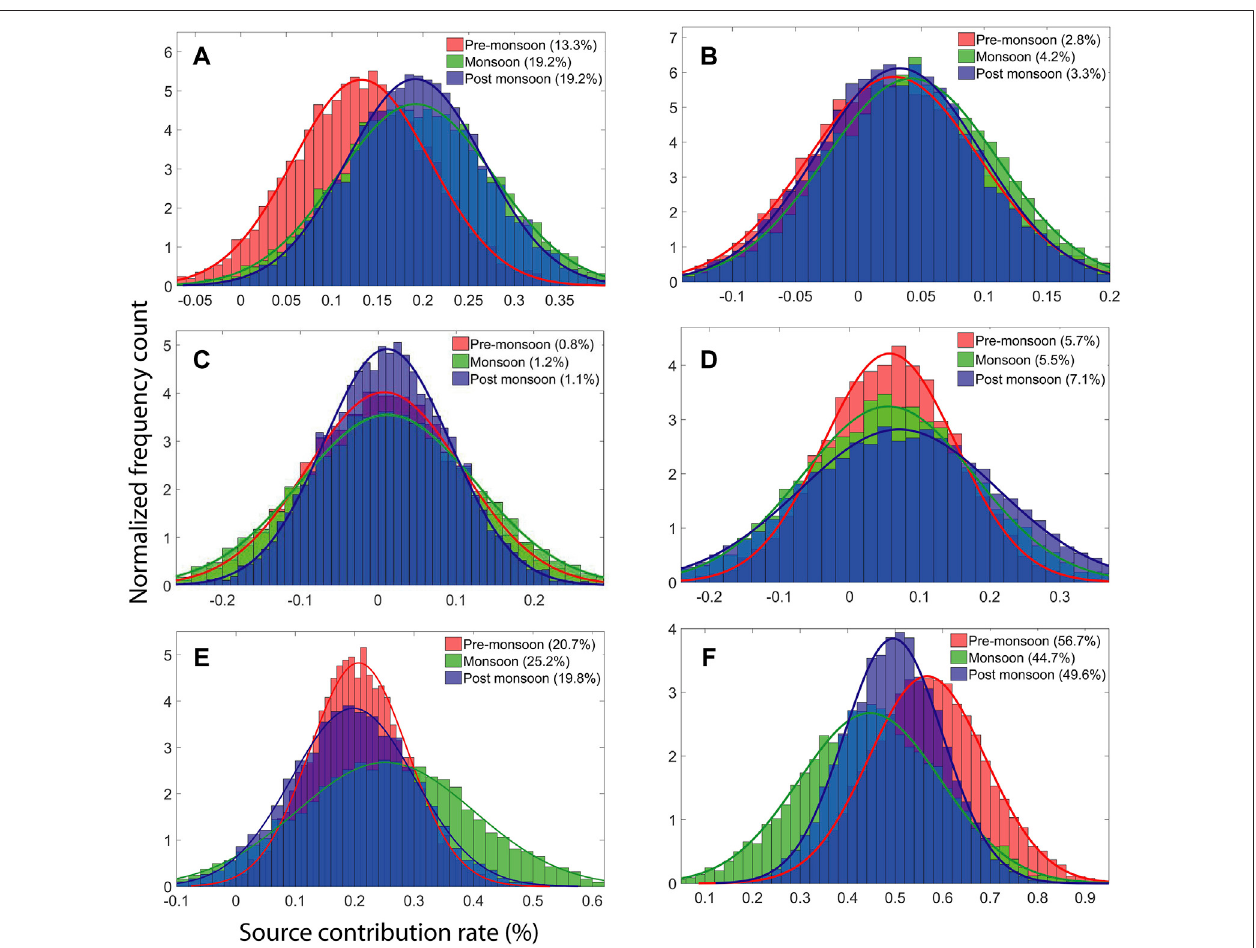
FIGURE 7 | Seasonal variation (pre-monsoon, monsoon, and post-monsoon) in the DOM contribution (in percentage, %) from various natural and anthropogenic sources in the environment to the downstream of the Ganges and Brahmaputra rivers in the pre-monsoon (March – June), monsoon (July – October), and post-monsoon (November – February).TheconsiderednaturalandanthropogenicDOMsourceshereare (A) algae, (B) groundwater, (C) industrialef fl uents, (D) soil, (E) terrestrialplants, and (F) sewerage